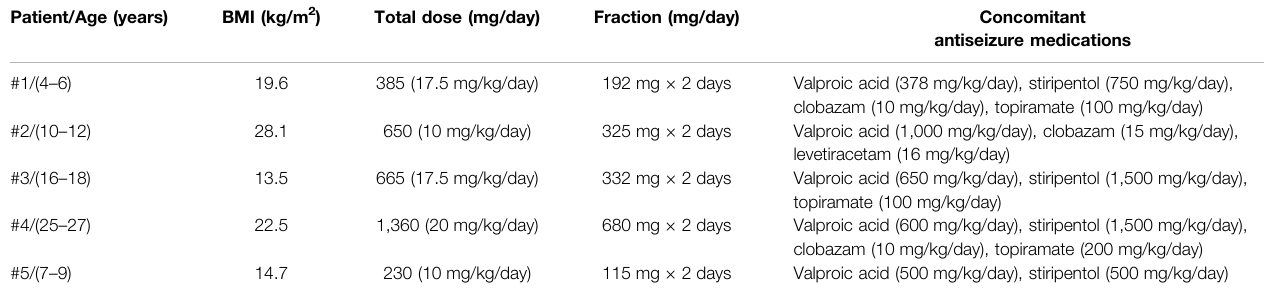
TABLE 1 | Demographic and clinical features of the patients.